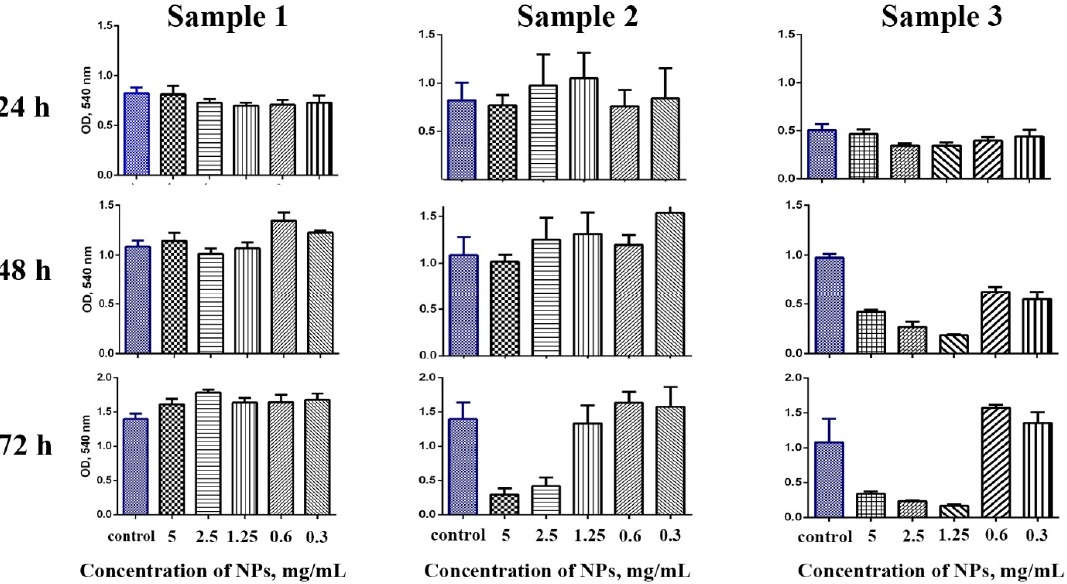
Figure 3. Analysis of hMSc viability according to MTT test. The cells were incubated with Ce 0.8 Gd 0.2 O 2 −х nanoparticles (0.3–5 mg/mL) for 24, 48 and 72 h. Ce 0.8 Gd 0.2 O 2 − x nanoparticles (0.3–5 mg/mL) for 24, 48 and 72 h.